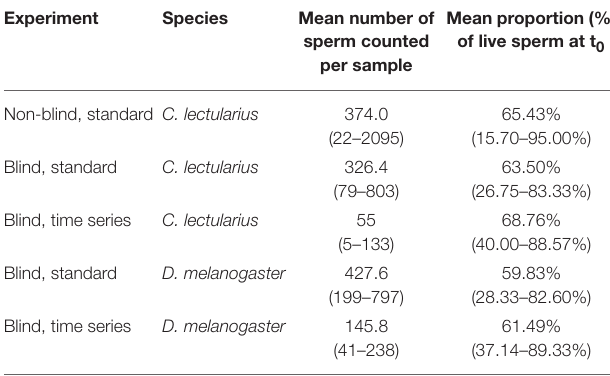
TABLE 6 | Sperm numbers and viability for the different protocols in Cimex lectularius and Drosophila melanogaster